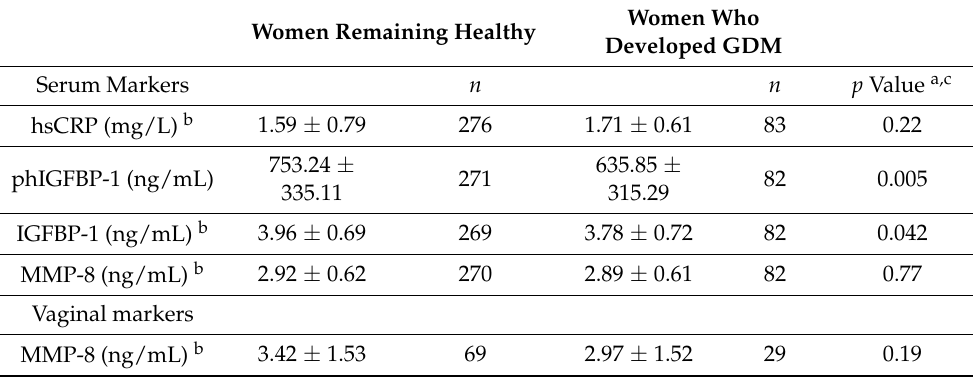
Table 3. The concentrations of serum matrix metalloproteinase 8 (MMP-8), phosphorylated insulin- like growth factor binding-protein 1 (phIGFBP-1) and IGFBP-1 and vaginal MMP-8 (mean ± SD) measured in early pregnancy in those women remaining healthy and in those who developed gestational diabetes mellitus (GDM) later in pregnancy. Women Who Women Remaining Healthy Developed GDM Serum Markers n